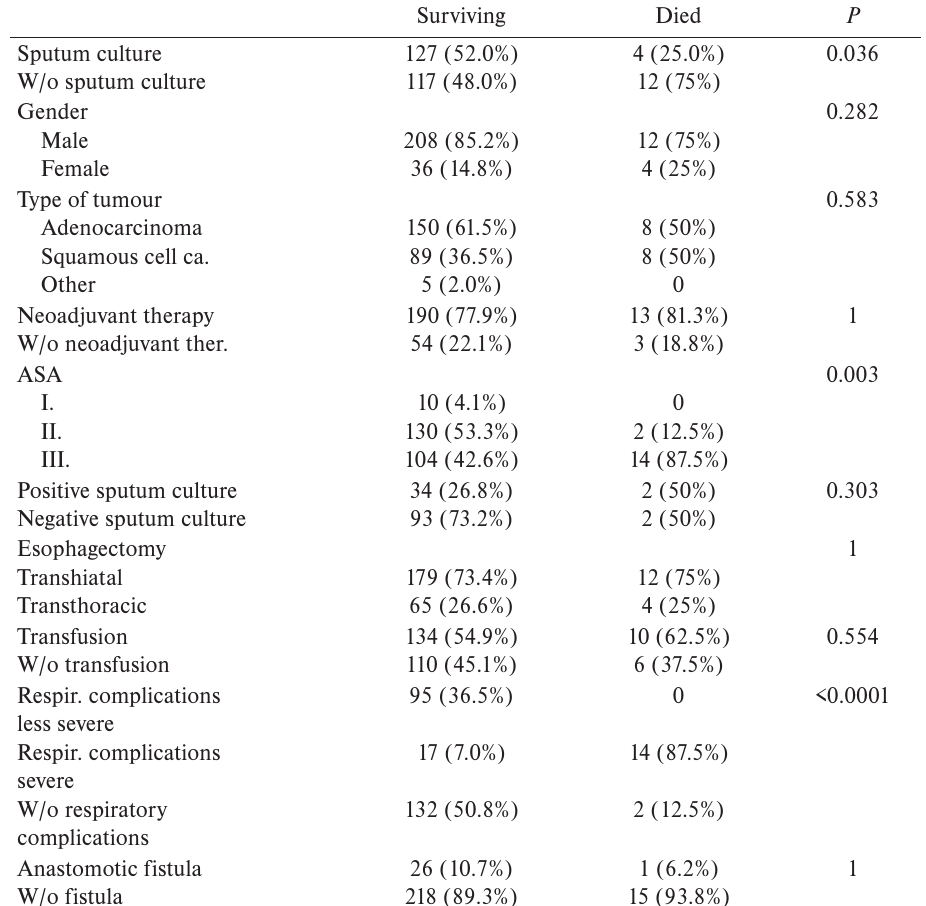
Table 4. Statistical evaluation of surviving patients and those who died postoperatively Surviving P Sputum culture